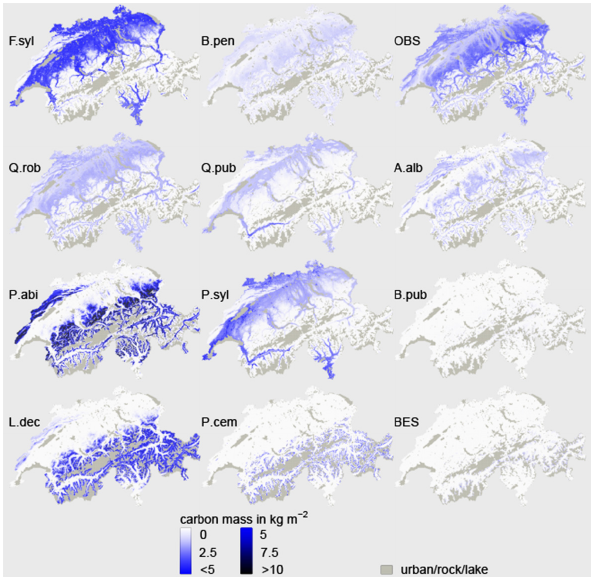
Figure D3. Carbon mass simulated with the adjusted parameter set for single species at 2100. A.alb: Abies alba ; B.pen: Betula pendula ; B.